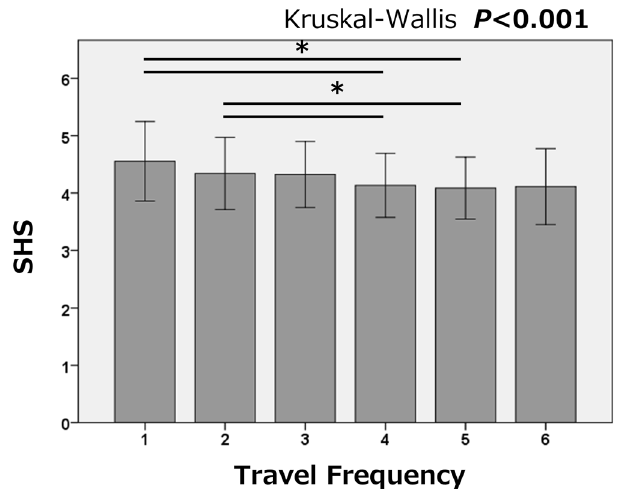
Fig. 1 Relationship between travel frequency and subjective wellbeing (Subjective Happiness Scale: SHS). Travel frequency: (1) More than 10 times per year, (2) 5 – 9 times per year, (3) 3 – 4 times per year, (4) 1 – 2 times per year, (5) Once in 2 – 3 years, (6) Less than once in 2 – 3 years (Hardly ever); SHS Subjective Happiness Scale. The bar charts show the scale score (mean ± SD). Signi fi cant SHS score difference between 1 – 4/5, 2 – 4/5, 3 – 4 (* p <